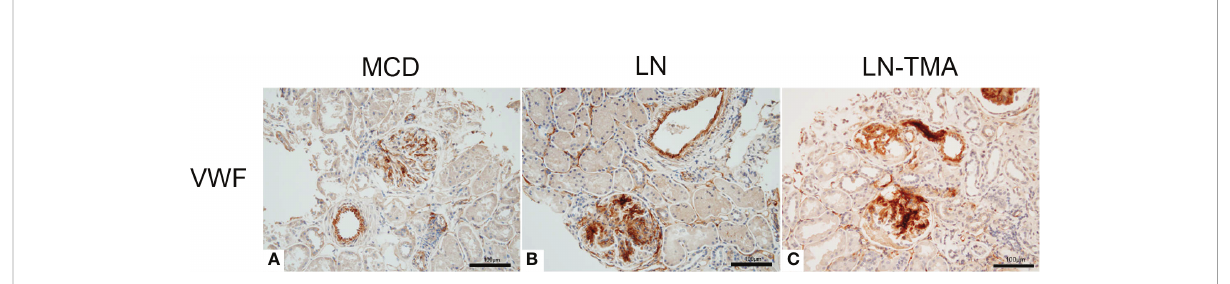
FIGURE 8 Paraf fi n sections for VWF (A-C) by immunohistochemistry among MCD, LN, and TMA patients. (A-C) The expression of VWF along the glomerular capillary and arteriole was strong, moderate, and weak in MCD (A) , LN (B) , and TMA (C) groups, respectively. Scale bars represent 100 m